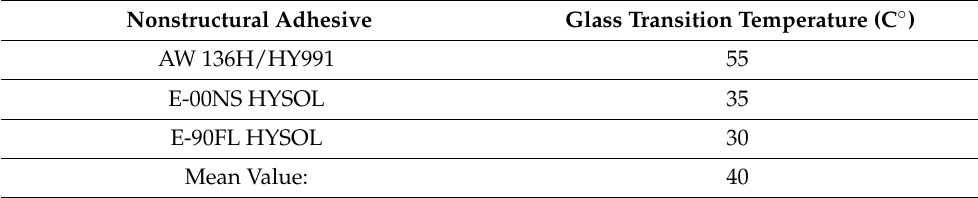
Table 13. Glass transition temperature of nonstructural adhesives.